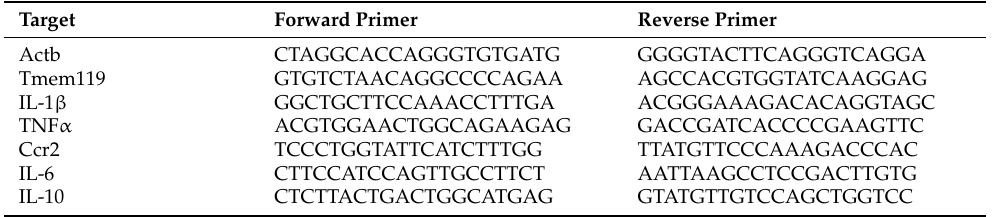
Table 1. Primers for real-time